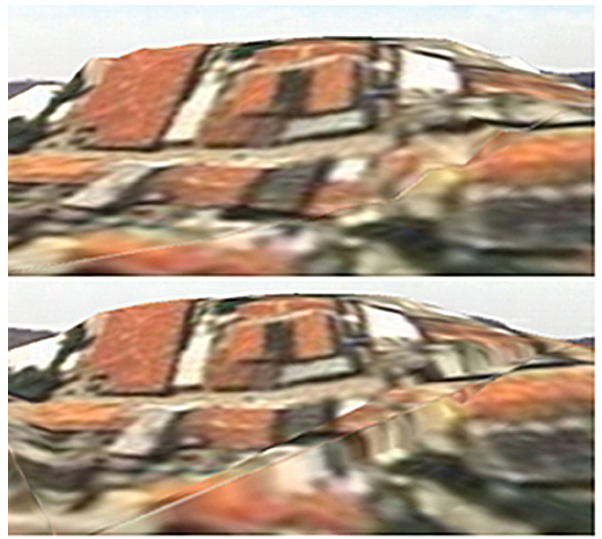
Figure 16. Textured model with continuous smooth transitions (top panel) and without continuous smooth transitions (bottom panel) between surfaces.